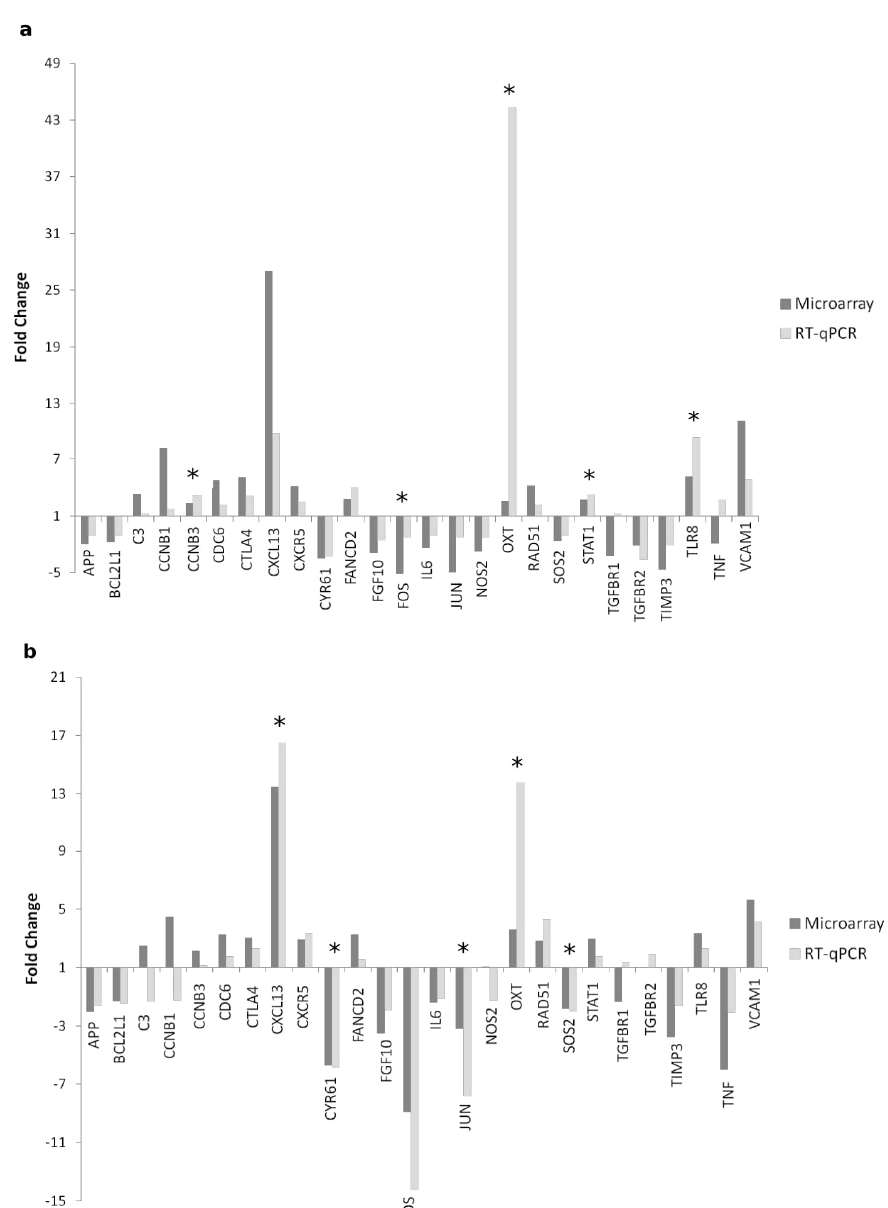
Figure 2. Expression of the selected 26 genes in a. Lesions group relative to Seronegative group b. Lesions group relative to Asymptomatic group measured by microarray and RT-qPCR. Bars represent the difference in Fold Change between groups of animals compared. Fifteen animals were included in the expression microarray and 18 animals in the RT-qPCR analysis. Statistically significant differences in the expression measured by RT-qPCR of the indicated genes are showed with an asterisk ( p < 0.05).